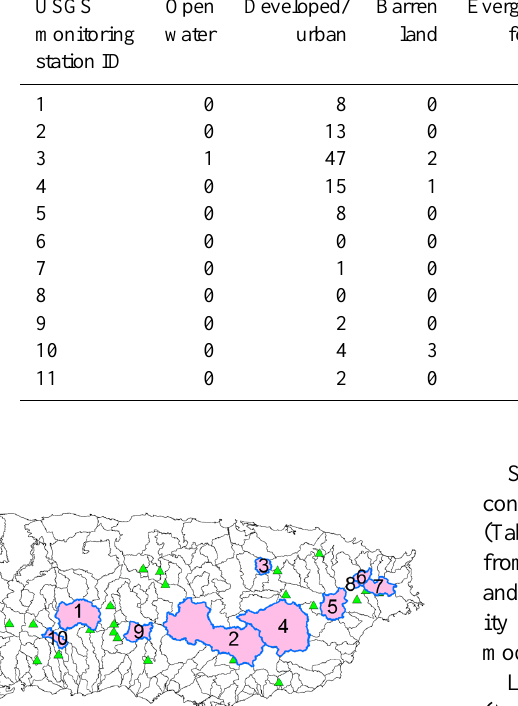
Table 2. Land use distribution (in percent of total watershed drainage area). USGS Open Developed/ Barren monitoring water land